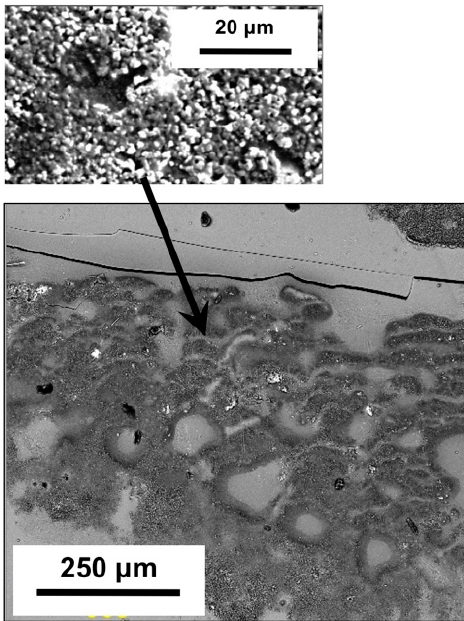
Figure 6. Appearance of the surface of a slag film in contact with the probe. Film recovered after 60 s of immersion of the probe in 1623 K mold flux (the film was almost glassy; secondary electron image).